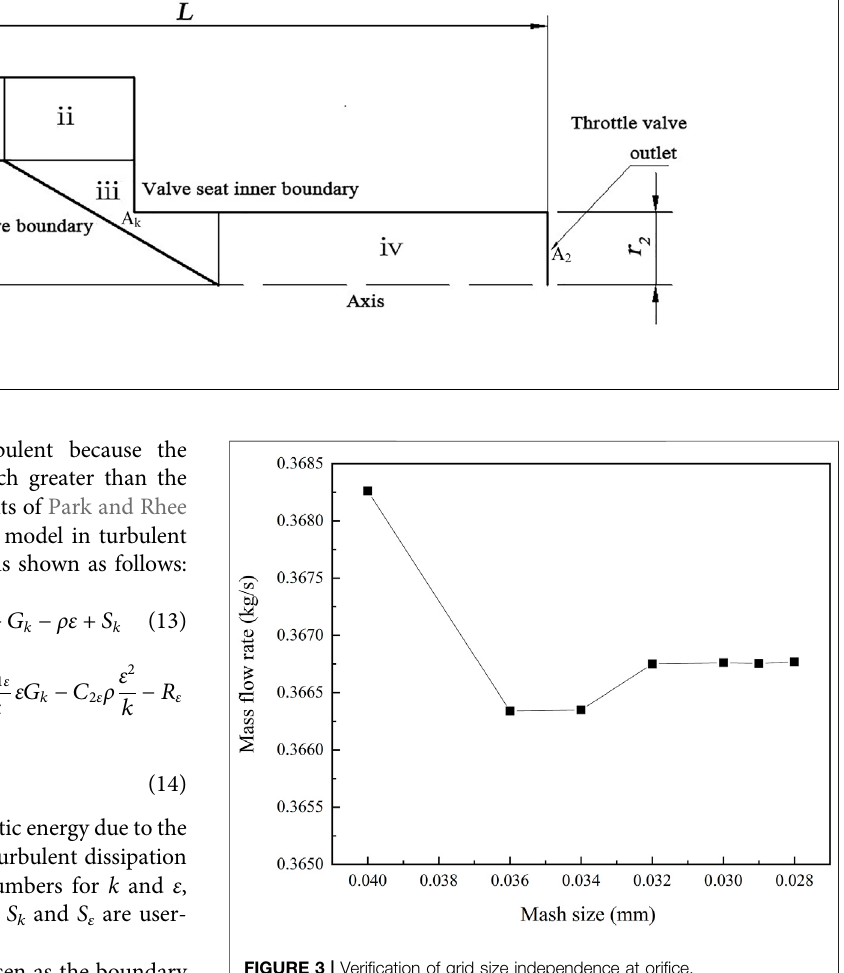
FIGURE 3 | Veri fi cation of grid size independence at ori fi